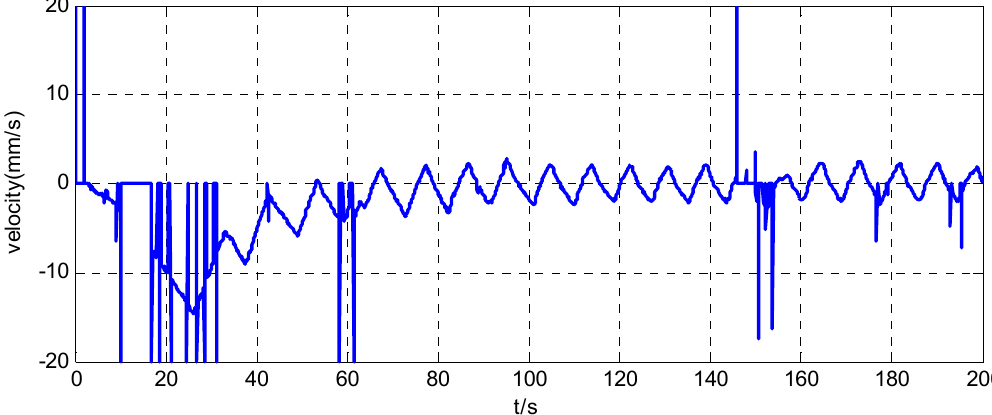
Figure 15. Velocity along the x-axis of the simulator when x ( 0 ) = 1036mm.